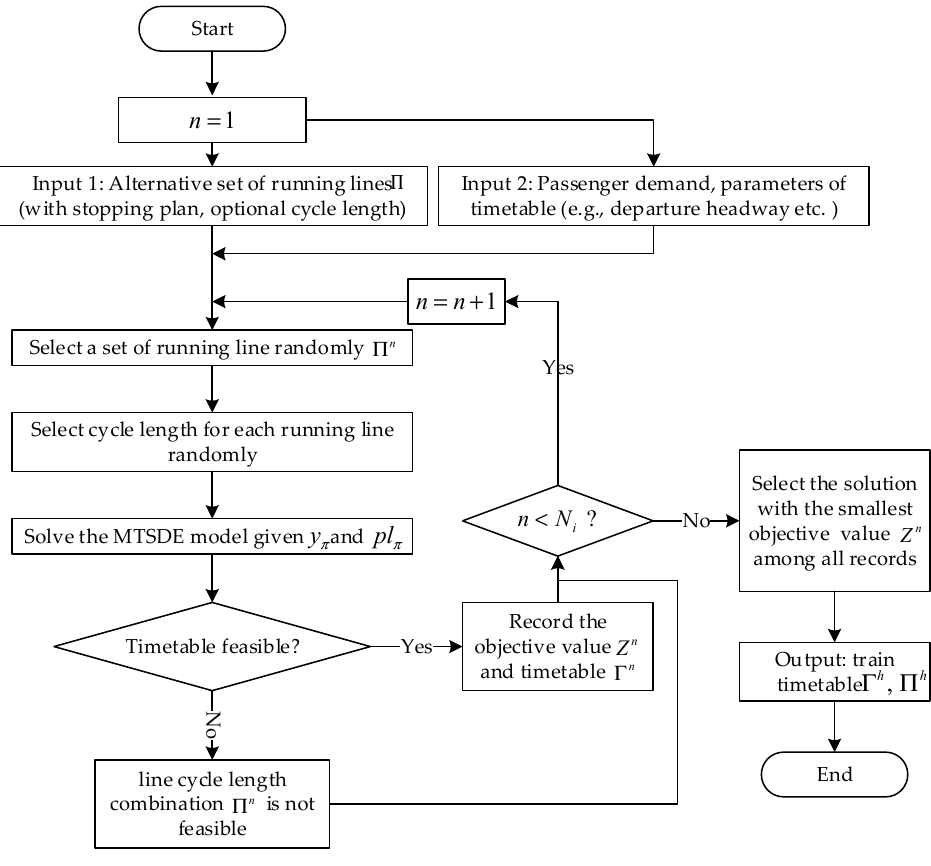
Figure 2. Solution framework based on alternative set